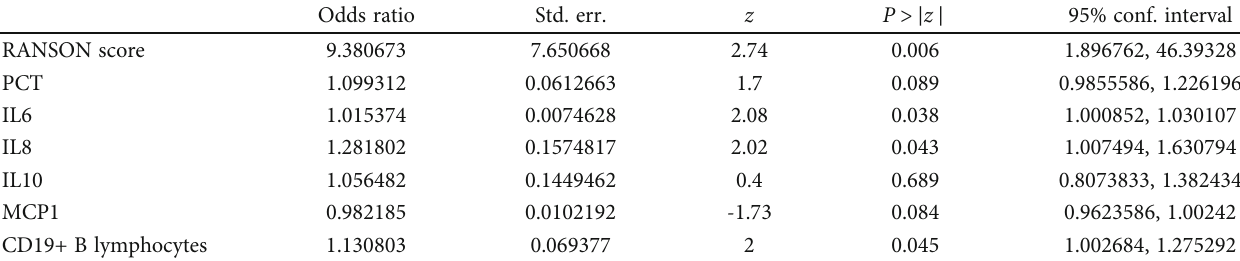
Table 4: Multivariate analyses of factors predicting